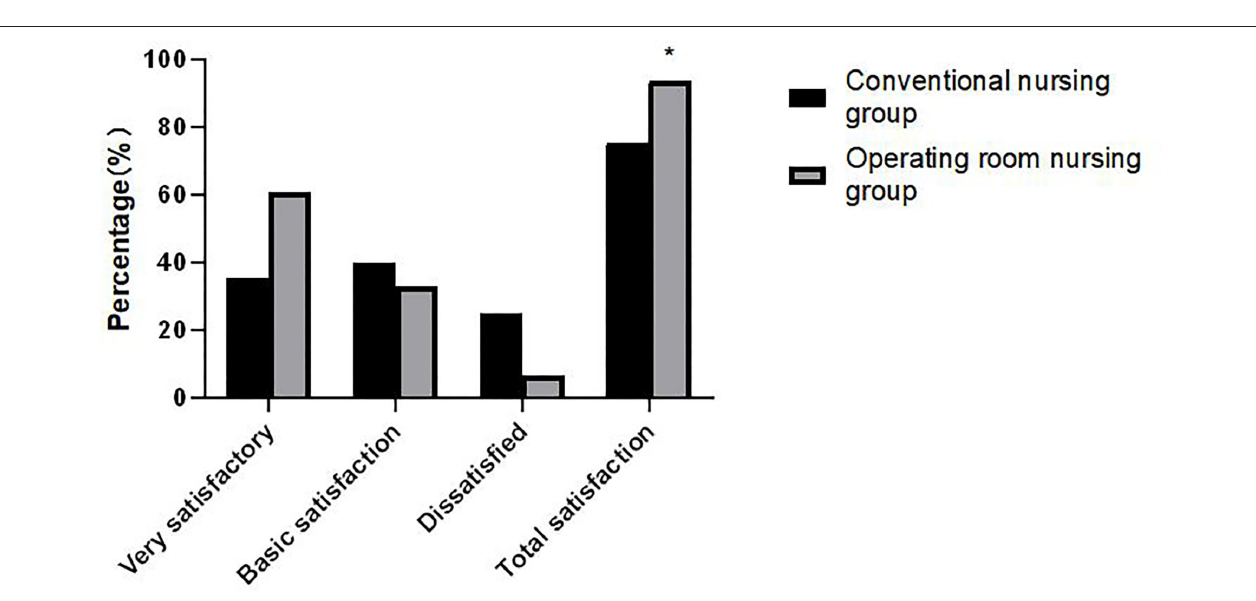
FIGURE 4 | Comparison of postoperative complications between the two groups. Compared with the conventional nursing group, * p < 0.05.